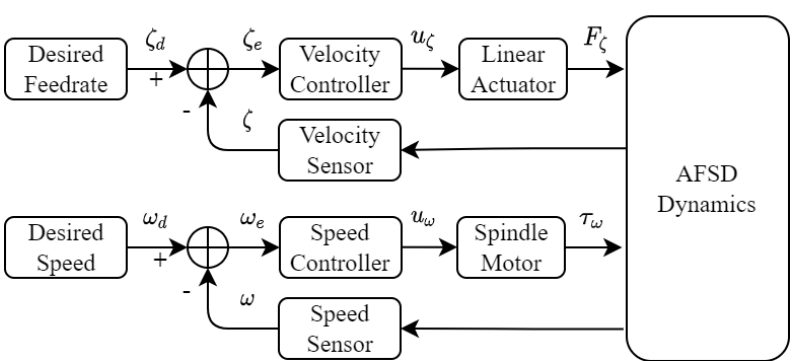
Figure 3. The preexisting inner loop feedrate and spindle speed controllers on the B8